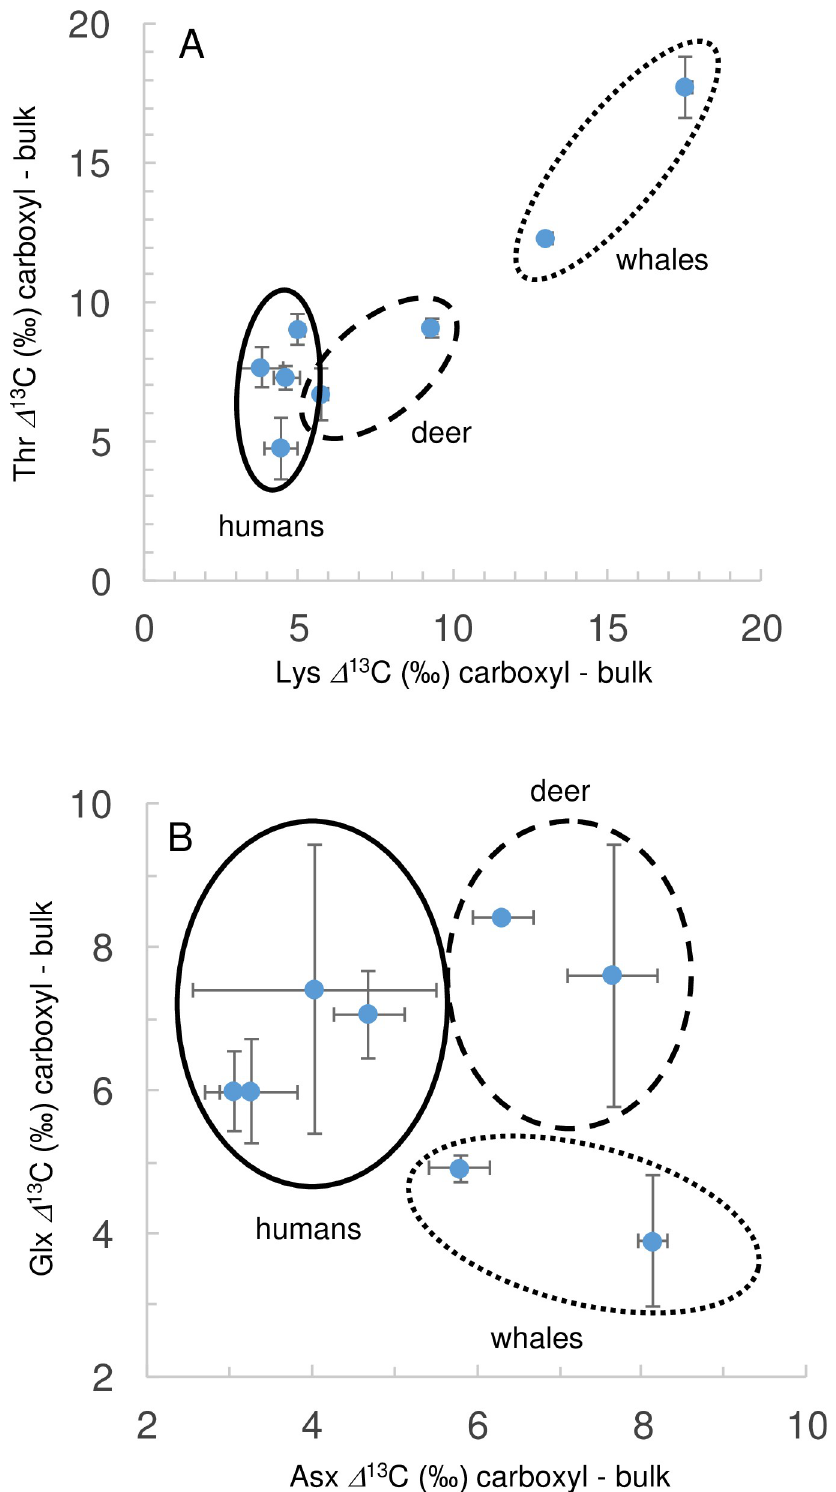
Fig 9. An illustration of how δ 13 C CARBOXYL values can be used to separate the 8 mammalian samples into taxon- specific groups; humans (solid line), whales (dashed line), deer (dotted line). (A) separations based on EAAs Lys and Thr, (B) separation based on NEAAs Asx and